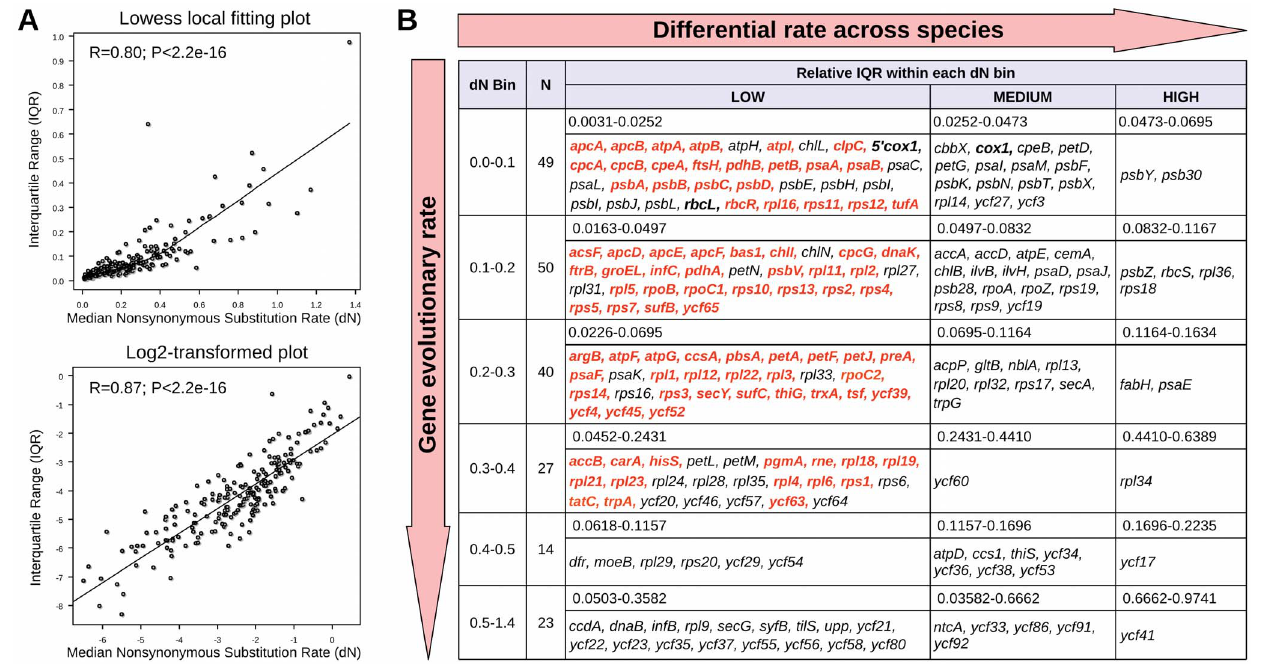
Figure 6. Assessing red algal plastid genes for phylogenetic and barcoding potential. (A) Comparison of median nonsynonymous substitution rate (dN) of protein-coding genes with interquartile range (IQR). The dN is positively correlated with the IQR (lowess local fit scatterplot, top), indicating that genes with higher evolutionary rate tend to show higher rate variations among species. When adjusted for data normality the positive correlation strength increases (log2-transformed scatterplot, bottom). (B) Summary of characteristics of individual genes. genes are binned according to their synonymous rate (vertical axis) and IQR (horizontal axis). Genes with a low IQR (right) and low dN (top) are potentially useful for higher level phylogenetic questions and distant species discrimination, whereas genes with low IQR (right) and medium-to-high dN (mid-to-bottom) are potentially useful for population studies and barcoding at subspecies level. Most promising candidate genes for phylogenies, barcoding, and population studies are in red (see